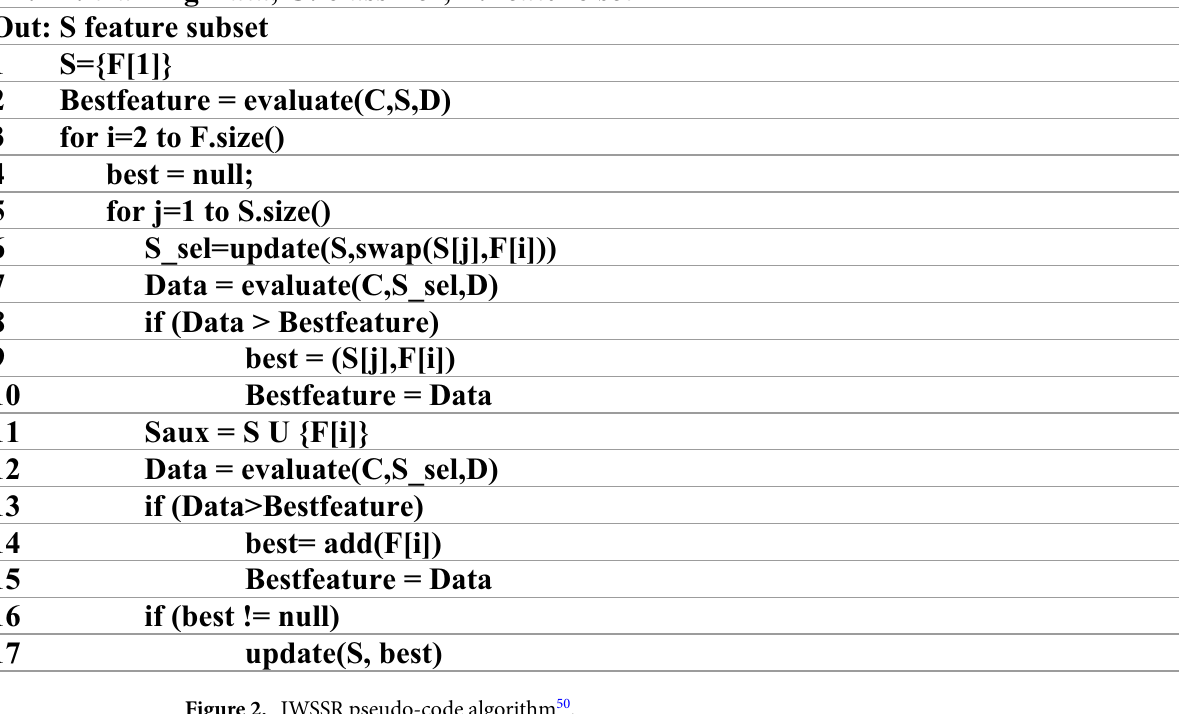
Figure 2. IWSSR pseudo-code algorithm 50 .